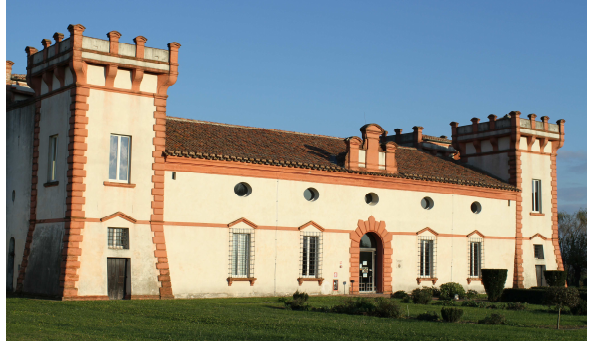
Figure 2: The test site, the “Delizia Estense del Verginese” castle (XV th